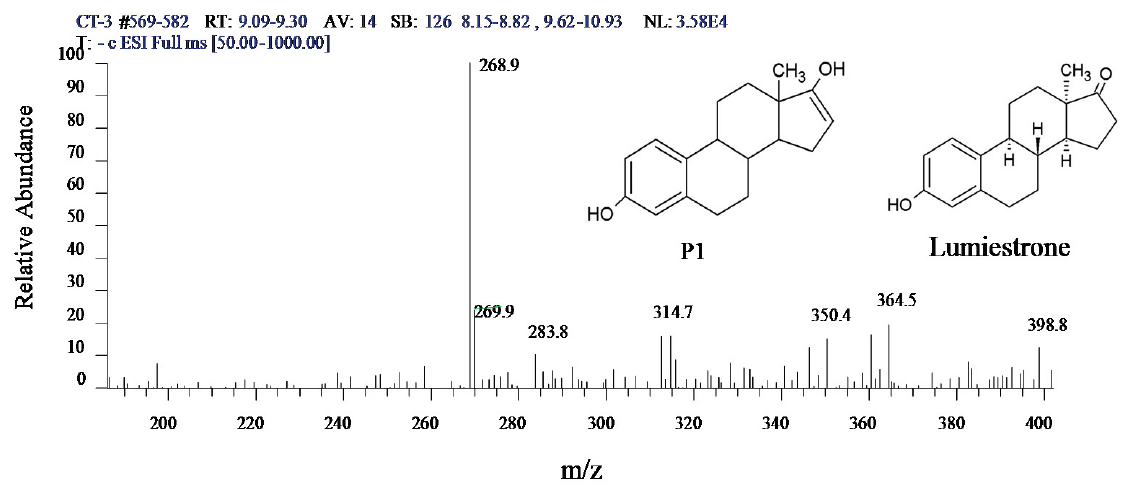
Figure 6. Mass chromatogram and the probable structure of intermediate